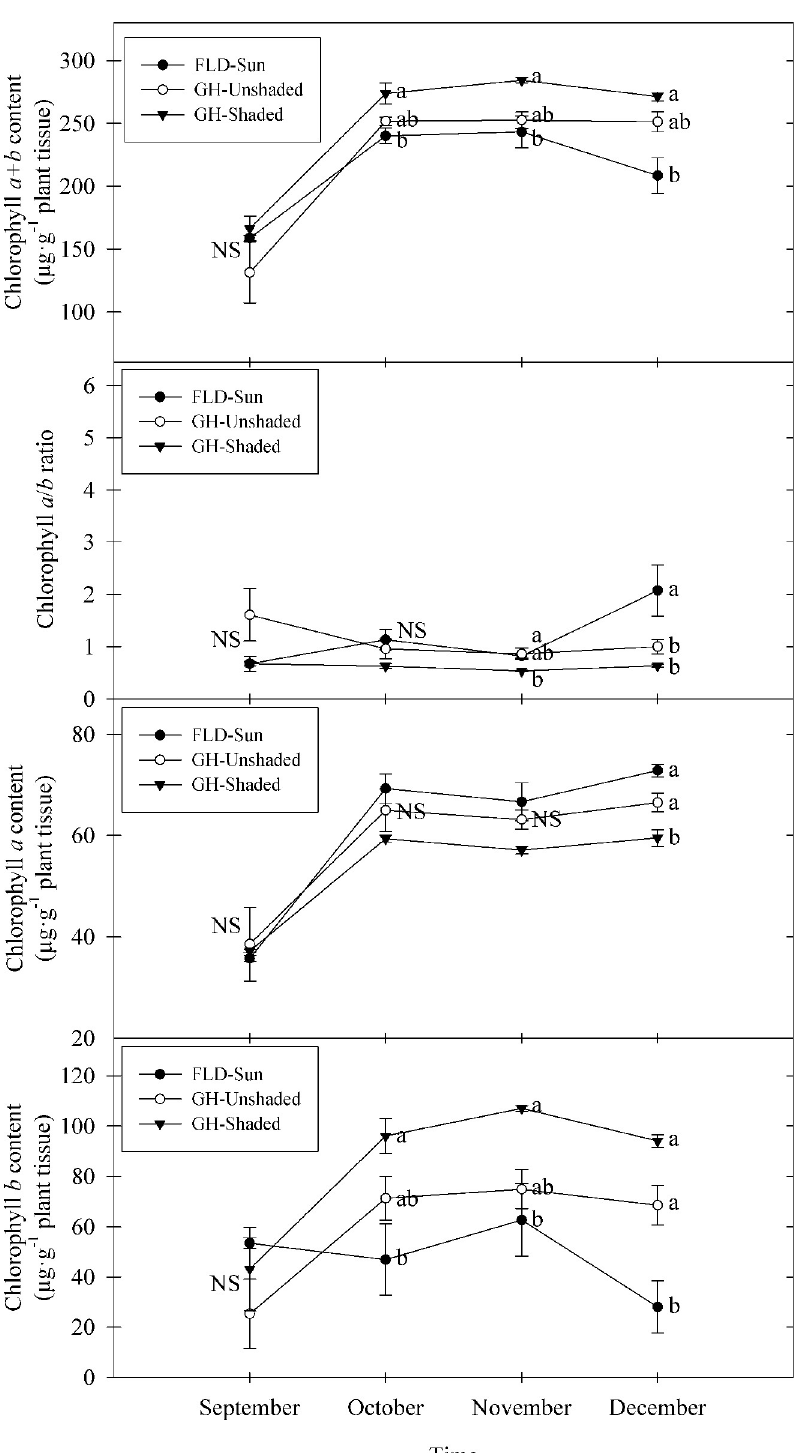
Fig 4. Chlorophyll a , b , a + b content, and chlorophyll a / b ratio of kratom cultivated under varying radiance. FLD = field; GH = greenhouse. Data were pooled from three random replicates per treatment for four months (n = 36). Means sharing the same letter are not statistically different by Tukey’s honest significant difference test at P < 0 . 05 . Error bars indicate the standard error. NS = not